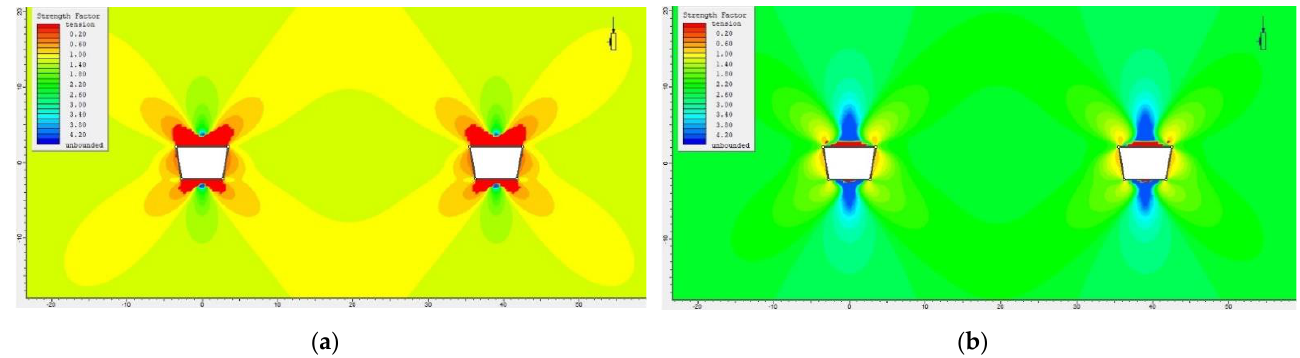
Figure 14. Distribution of strength factor values in the cross-section through ramps drilled in: ( a ) sandstone; ( b ) dolomite.